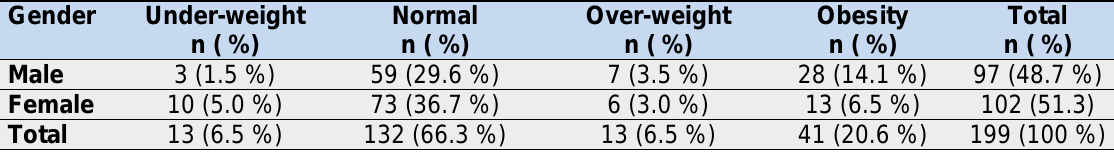
Table 1: Number and percentage of nutritional status of children (n=199)